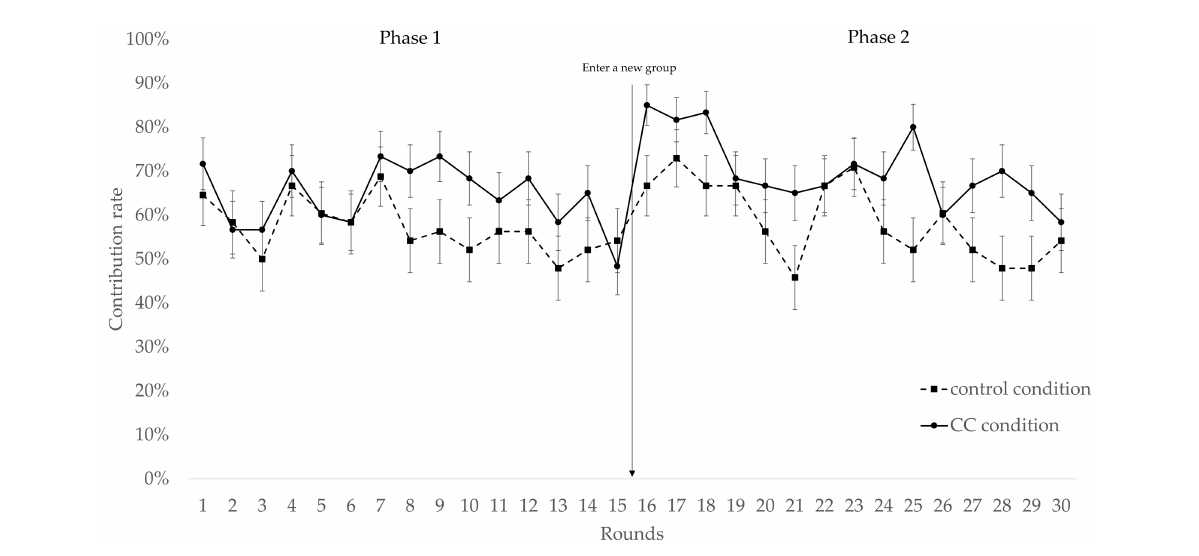
FIGURE 2 Participants’ rate of contribution to the group account for the two phases of the all-or-none public goods